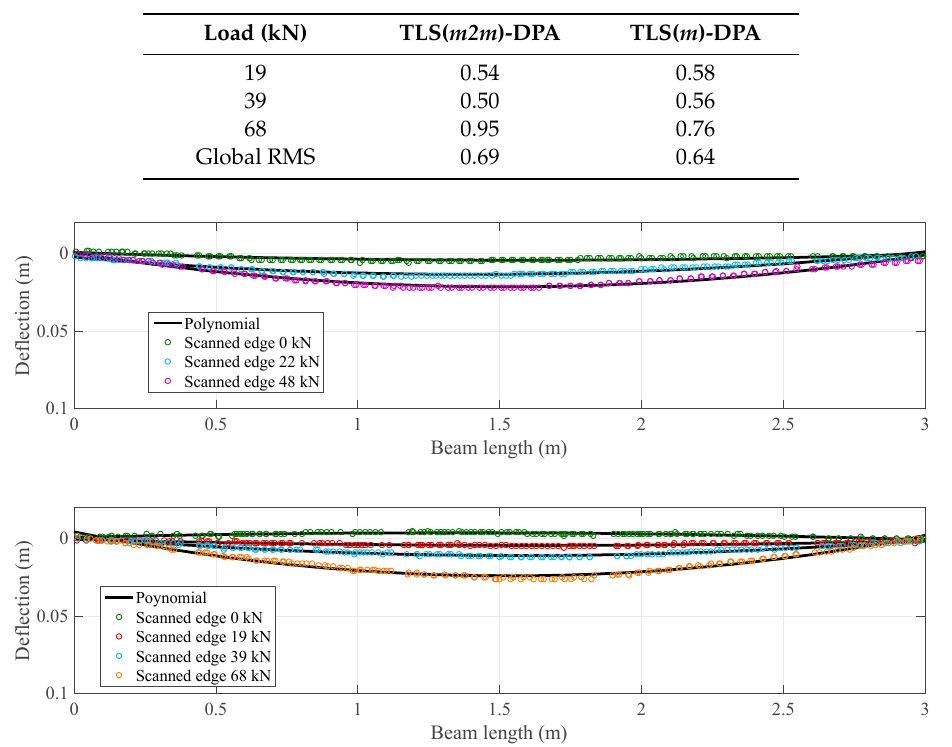
Table 8. RMS (mm) of each TLS methodology with DPA beam#2.